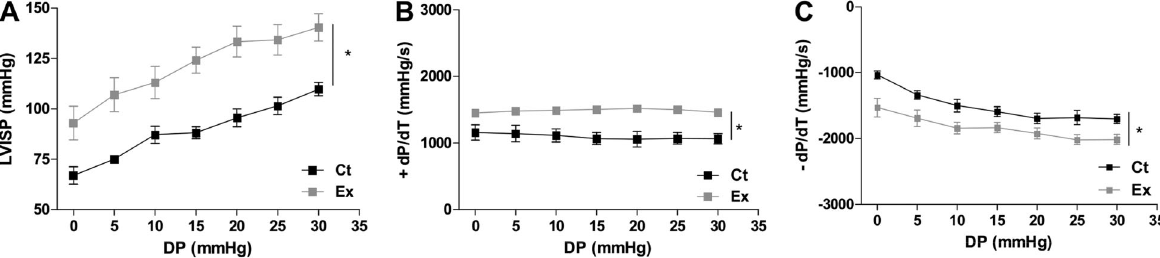
Figure 2. Contractility values from isolated heart. A , left ventricular isovolumetric systolic pressure (LVISP); B , positive fi rst time derivative ( + dP/dt), and C , negative fi rst time derivative ( (cid:1) dP/dt) curves obtained at different diastolic pressures (DP) from control (Ct, n=6) and exercised (Ex, n=6) spontaneously hypertensive rats (SHR). Results are reported as means ± SE. *P o 0.05 (two-way